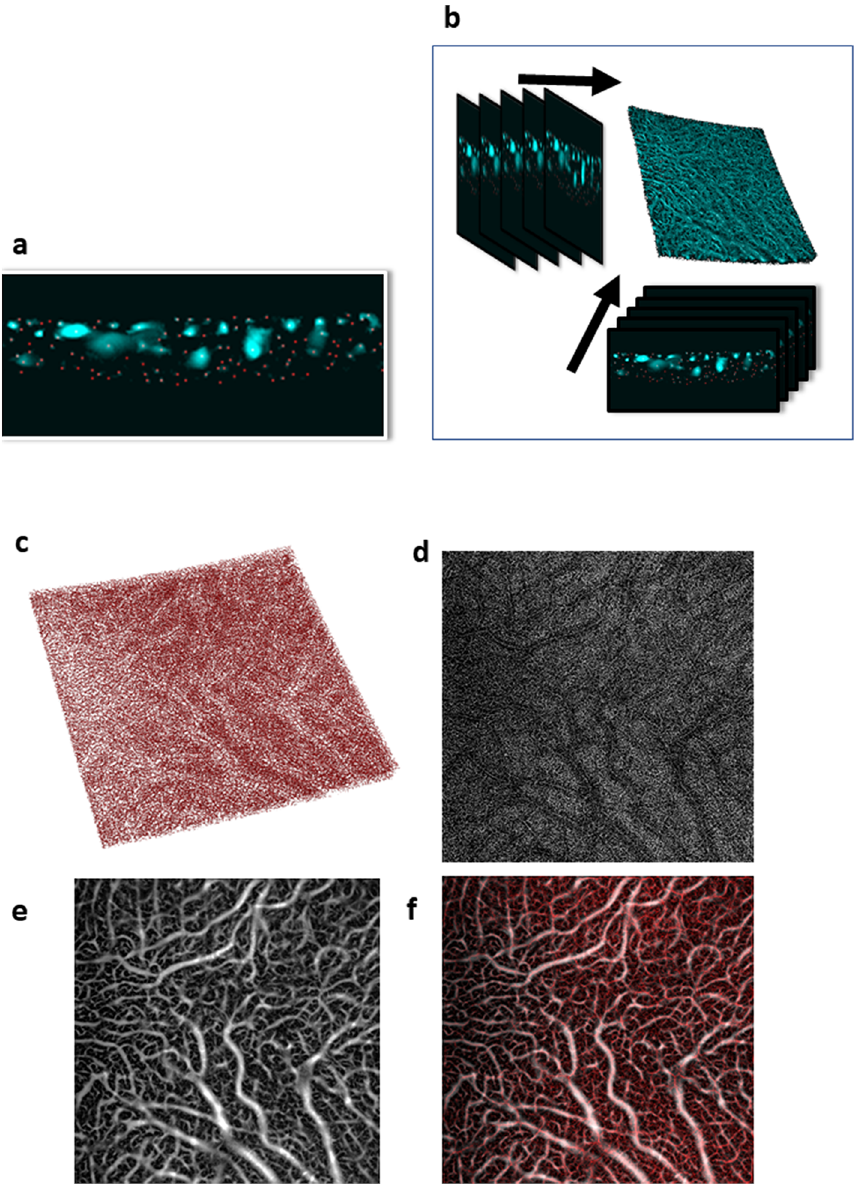
Figure 1. Vessel line visualization. The local high-intensity points are detected using the ImageJ function, “Find Maxima” for each slice after multiscale Hessian enhancement ( a ). The same procedure is repeated along the x-axis and z-axis. Both images are combined to make a three-dimensional line model ( b ). A three-dimensional view of the centreline reconstruction model ( c ). An en-face projection image of the centreline reconstruction model ( d ). An en-face projection image of the choroidal vasculature ( e ). A composite image of B and C ( f